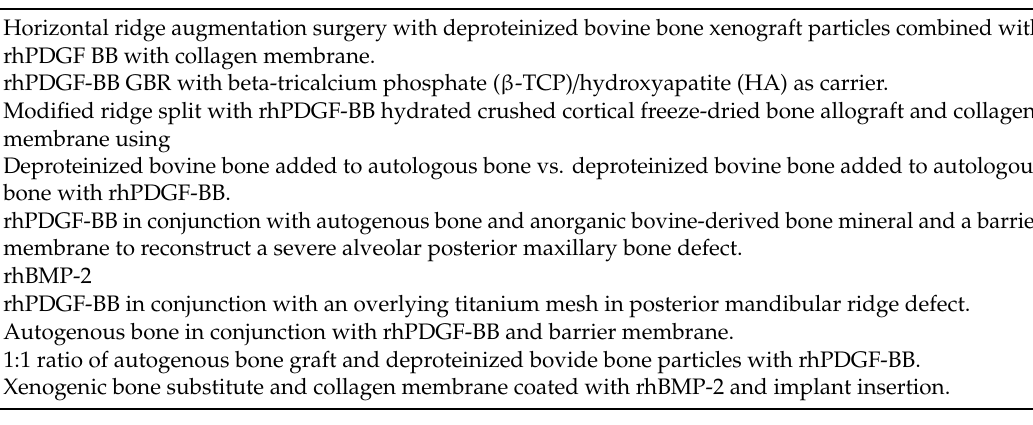
Horizontal ridge augmentation surgery with deproteinized bovine bone xenograft particles combined with rhPDGF BB with collagen